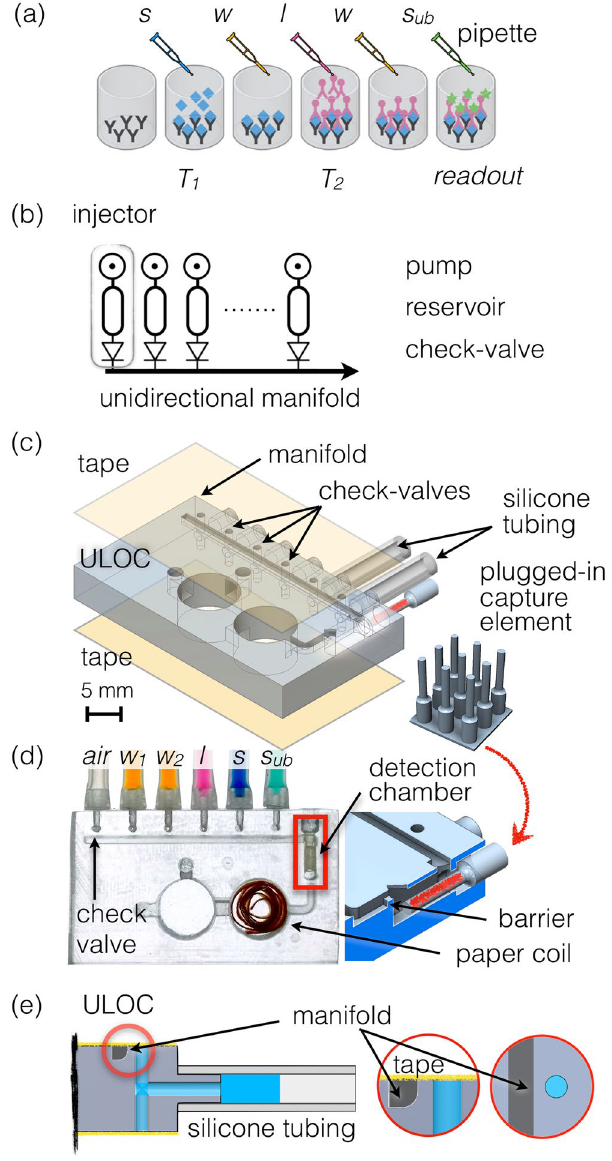
Figure 1. ( a ) Scheme of ELISA assay performed on a microplate. The sample ( s ) is pipetted into the functionalized well and after incubation ( T 1 ), washing buffer ( w ) is applied. Subsequently label ( l ) is pipetted and incubated ( T 2 ), followed by another washing procedure and a final delivery of enzyme substrate ( s ub ) for readout at a defined endpoint. ( b ) Scheme of the unidirectional manifold served by multiple injectors composed by a pumping element, a reservoir and a check-valve. ( c ) ULOC of 3D CAD highlighting the valve configuration and plugs to silicon tubing pumps, as well as the montage of the separately functionalized plugged-in capture element into the detection chamber, and the tape sealing. The inset show the separate 3D printout of the detection chamber elements. ( d ) Image of an assembled device ready for operation. The 3D model underscores the plug-in functional element and the geometric barrier assisting volume metering. ( e ) Detail of the injector with the check-valve body showing the 500 μ m long barrier between the valve and the manifold, and the role of the sealing tape as elastic element to control unidirectional flow towards the